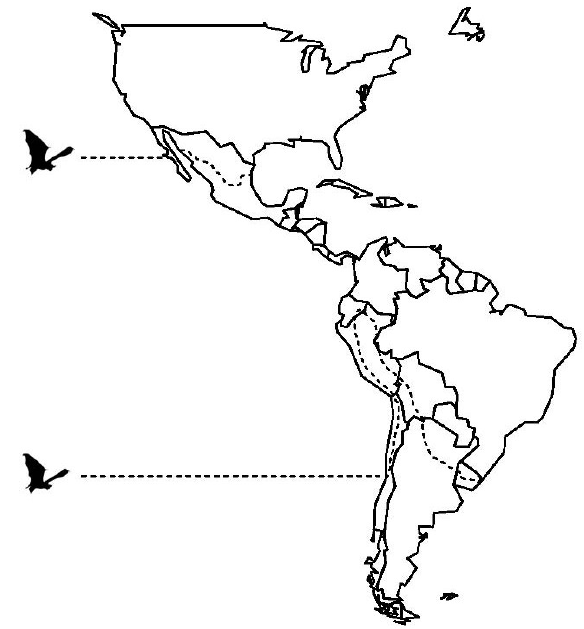
Figure 2. Limits of distribution (dashed line) for all vampire bat species in Latin